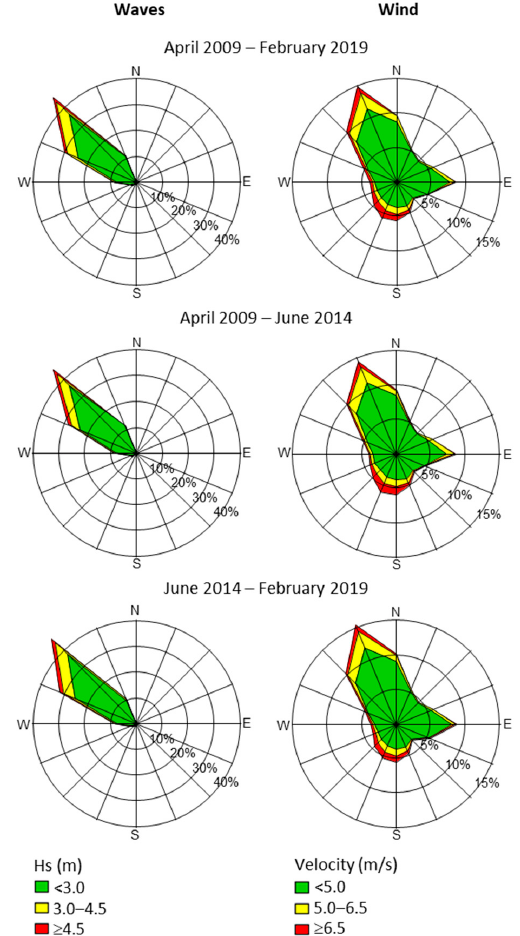
Figure 3. Distribution of 3-hourly wave directions for three significant-wave-height classes ( left plots ) and of hourly wind directions for three velocity classes ( right plots ) for the last decade and the two 5-year periods.